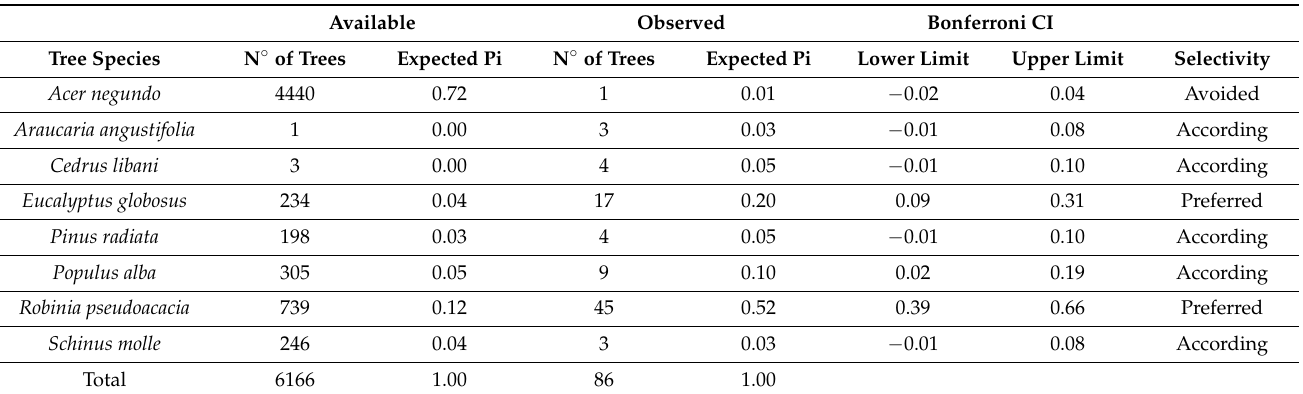
Table 2. Eight tree species where we found Monk Parakeets nests in La Reina and represented in the municipality’s census (available versus observed). Abundance and proportion of trees are compared to confidence intervals to test for Monk Parakeet selectivity. Pi = Proportion of trees of the i species. CI = Confidence interval. Available Observed Bonferroni CI Lower Limit Upper Limit